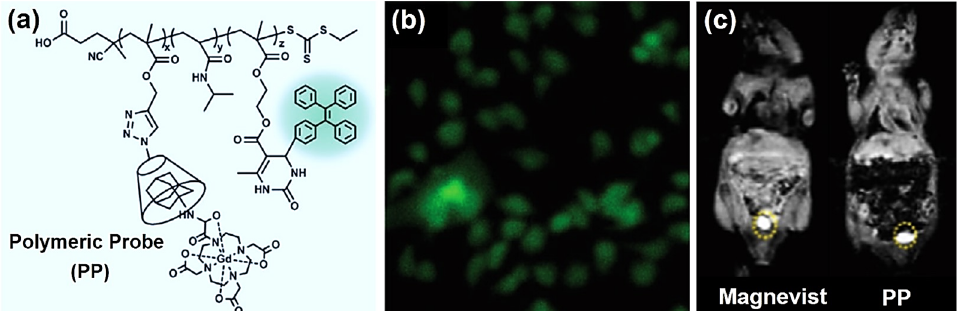
Figure 9. Dual-modal polymeric probe (PP) for fluorescence cell imaging and 1 H magnetic resonance imaging (MRI). ( a ) The molecular structure of PP; ( b ) fluorescence images of HeLa cells stained with PP solution (50 µg/mL). ( c ) The T 1 -weight MRI of mouse kidneys with Magnevist and PP (150 µL, equivalent 0.5 mmol/L Gd 3+ , and intravenous injection) as contrast agents. Reprinted with permission from ref. [68] . Copyright © 2021 Wiley-VCH GmbH. All rights reserved.